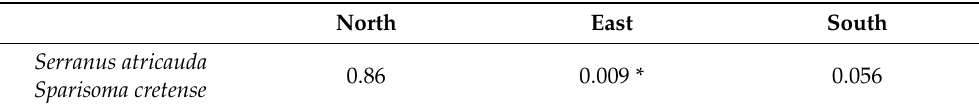
Table 4. Results of the two-way PERMANOVA analyzing the variation in the content of heavy metals and trace elements in muscle tissue in species according to study zone, considering the level of the factor “Zones”. North East South Serranus atricauda 0.86 0.009 * 0.056 Sparisoma cretense